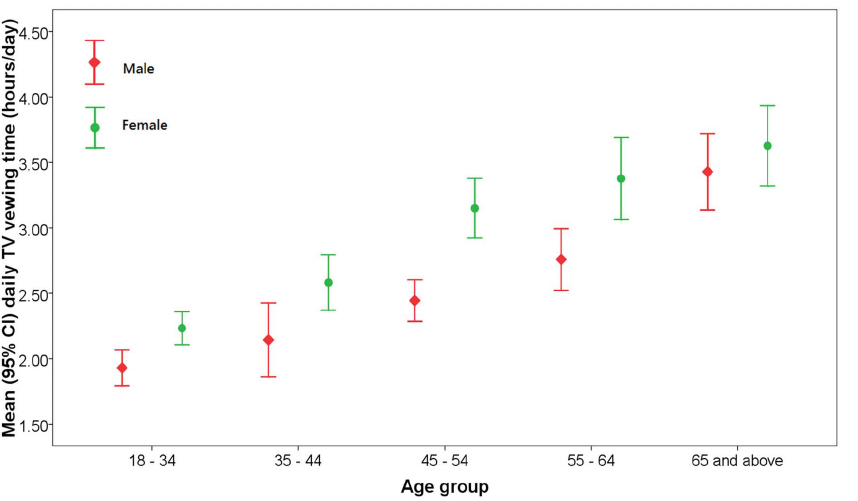
Figure 1. Mean hours of TV viewing daily by age and gender in Hong Kong, 2009–2010. Weighted to the total Hong Kong 2009 and 2010 population, respectively.